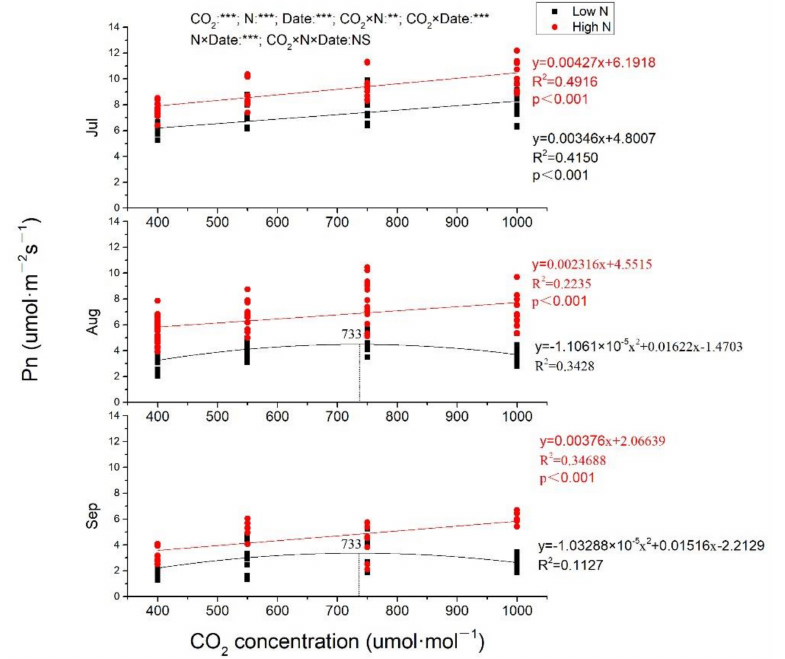
Figure 2. The different responses of photosynthate rate to elevated CO 2 at low N and high N treatments. Pn, photosynthate rate. CO 2 : different CO 2 concentrations; N: N fertilization; Date: measuring time; ***, **: significant at 0.001 and 0.01 level; NS: not significant; Jul: July; Aug: August; Sep: